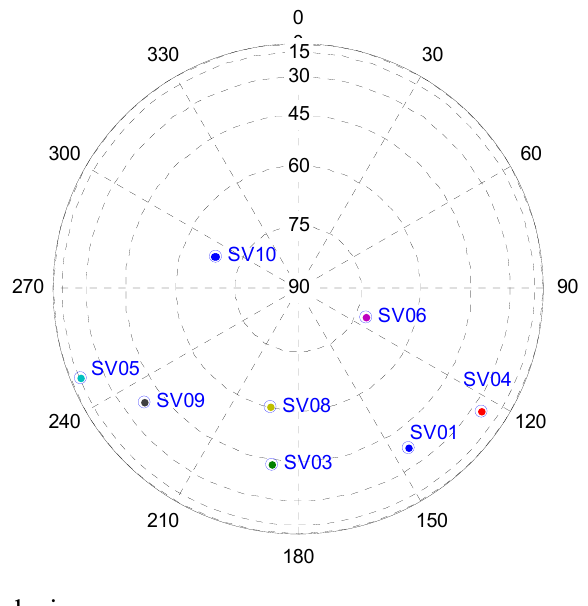
Figure 10. COMPASS satellite sky-plot of field test.